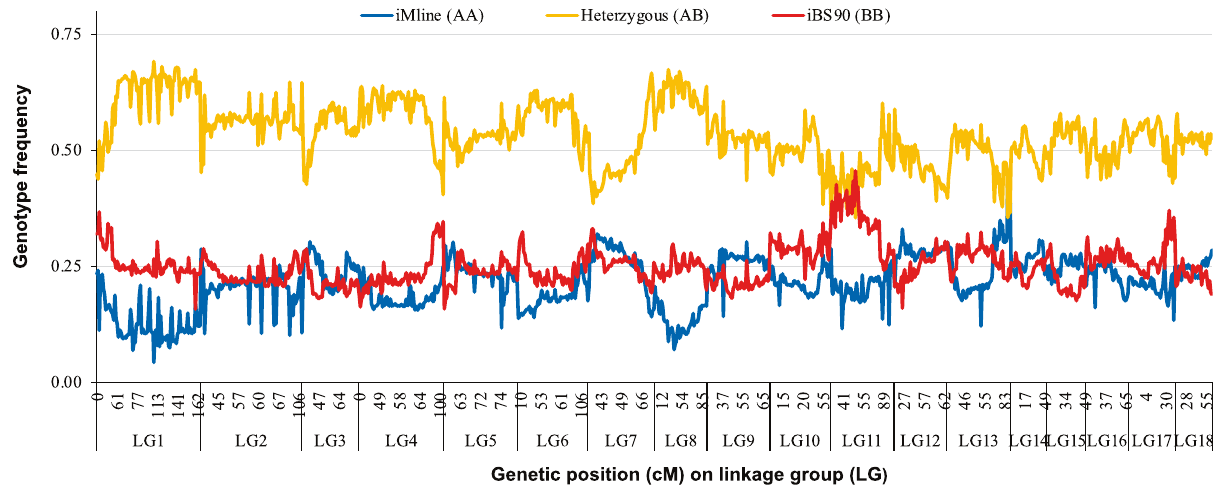
Fig. 5 The proportion of contributing alleles from iM line (AA) and iBS90 (BB) for each marker on the 18 linkage groups. Parental allele contributed by iM line and iBS90 is represented in blue and red, respectively, whereas heterozygous contributed by both parents is indicated in